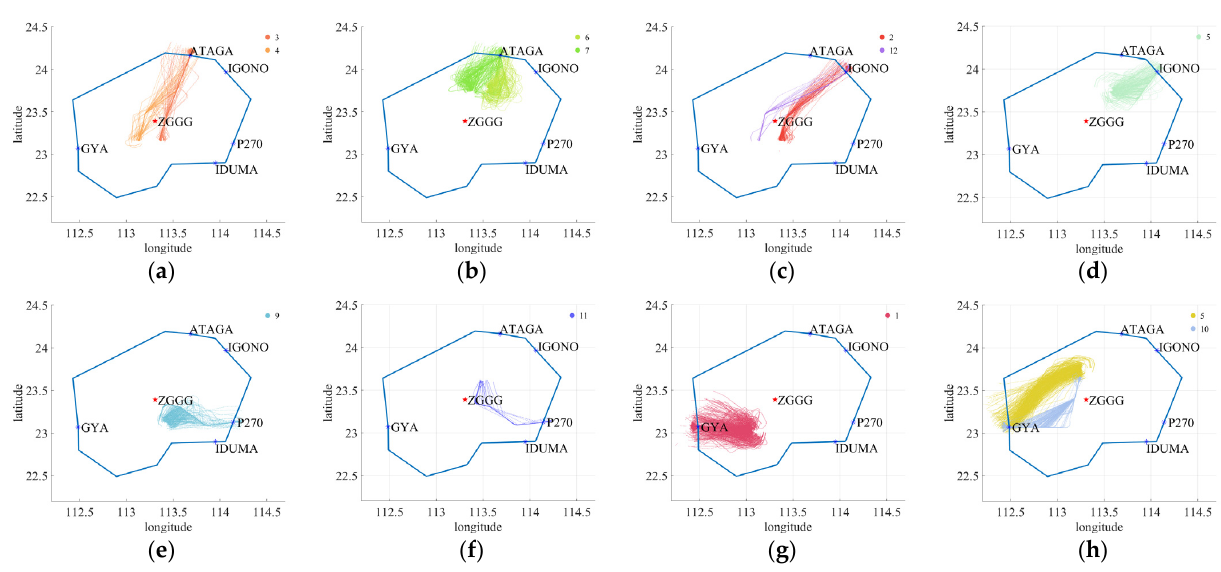
Figure 7. Clustering results of flight trajectories of ZGGG (OPTICS). ( a ) AG: ATAGA, Direction: